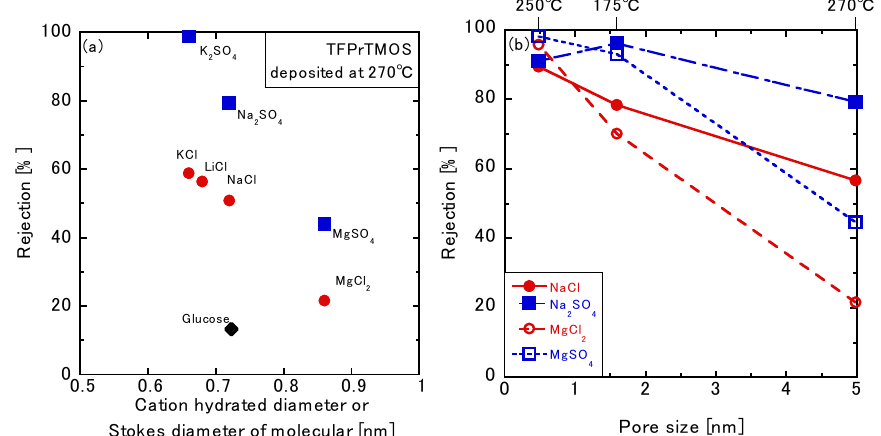
Figure 8. ( a ) Relation between ion rejection and hydrated ion diameter (or Stokes diameter of glucose) for TFPrTMOS-derived membranes deposited at 270 ◦ C. ( b ) The relationship between the pore size and ion rejections of the TFPrTMOS-derived membrane deposited at 175 ◦ C, 250 ◦ C, and 270 ◦ C. Table 3. The order of ion rejection, glucose rejection, and pore size in silica and polymeric membranes. Membranes